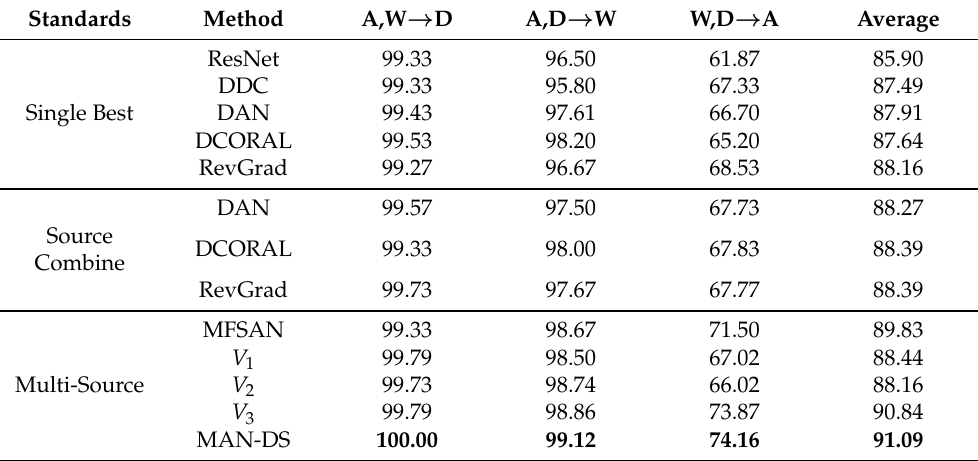
Table 1. Performance comparison of classification accuracy (%) on Office-31 dataset.